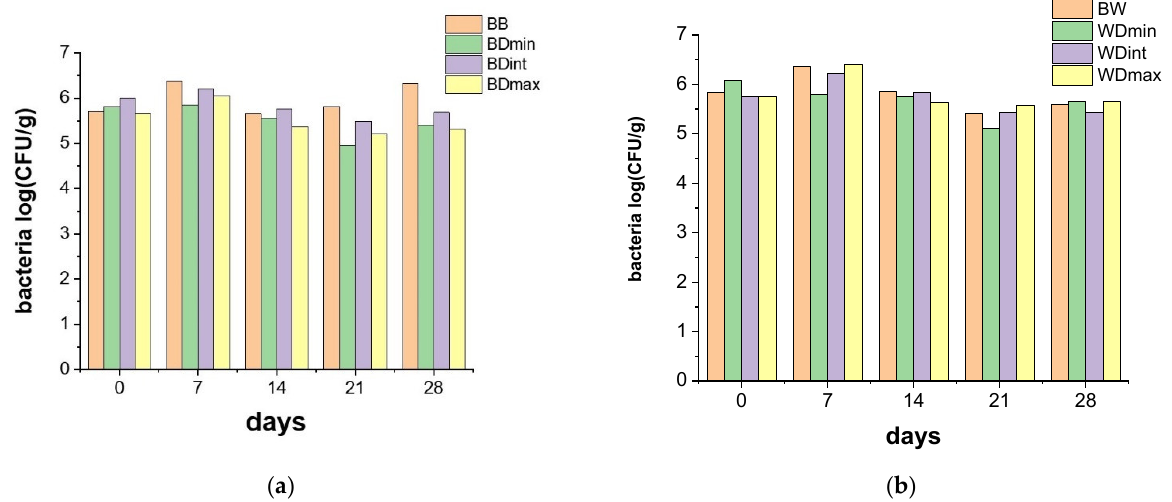
Figure 5. The effects of the treatment of barley ( a ) and wheat seeds ( b ) with TTZ on the communities of bacteria, recorded every 7 days for 28 days: BB and BW—seeds untreated with triticonazole, BDmin, and WDmin—barley and wheat seeds treated with the minimum dose, DBint, and WDint— barley and wheat seeds treated with the intermediate dose, BDmax, and WDmax—barley and wheat seeds treated with the maximum dose of triticonazole.